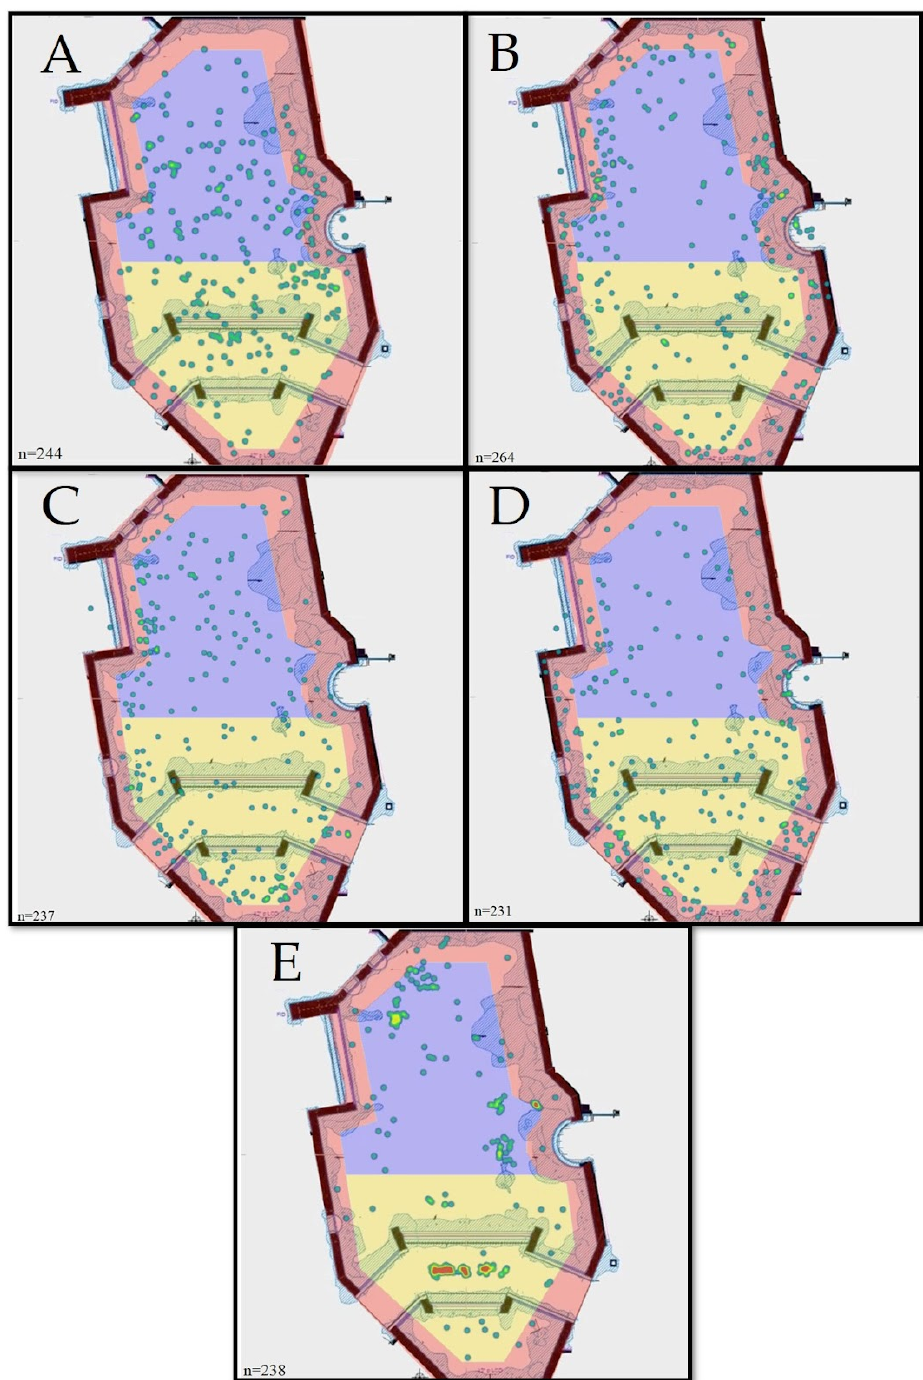
Figure 2. Heat maps generated for the Exhibit Use of all five individuals. The heat maps are labeled as follows: ( A ) bonnethead shark; ( B ) blacknose shark; ( C ) blacktip reef shark; ( D ) smooth dogfish; and ( E ) nurse shark. Zone ‘A’ is colored in yellow, zone ‘B’ is blue, and zone ‘C’ is red. Blue and green dots represent 1–2 data points, whereas reds and yellows represent large clusters of data points (3 or more).